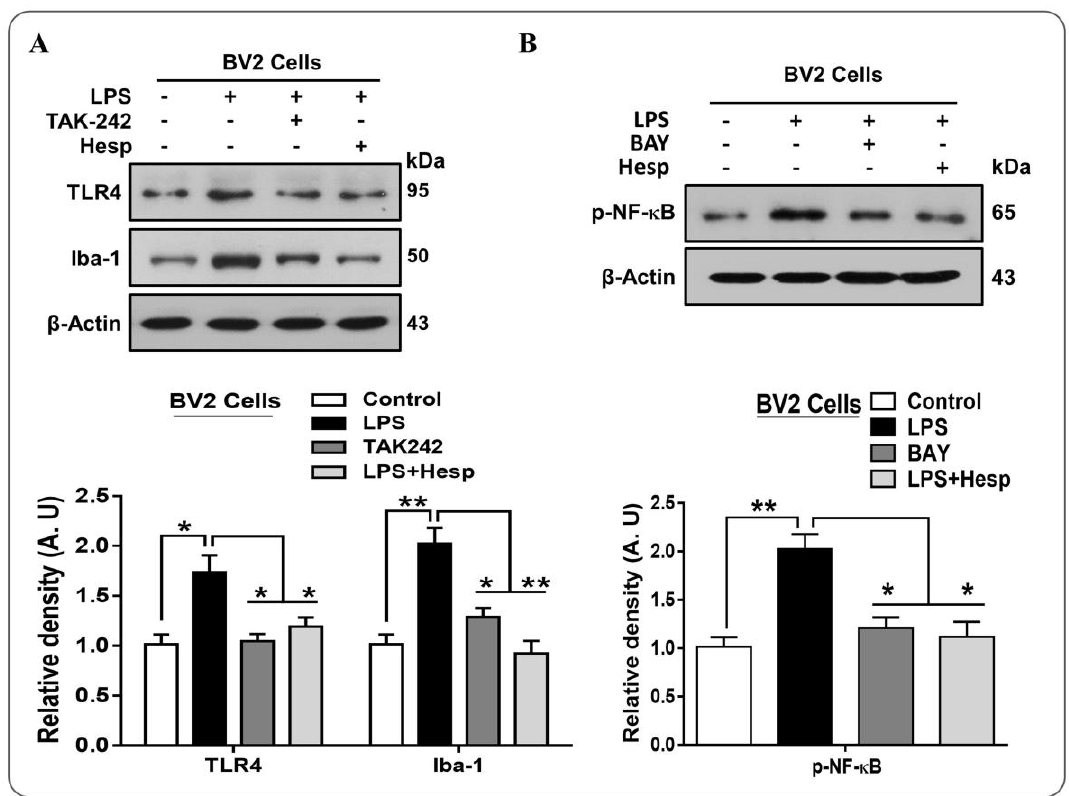
Figure 4. ( A ) Western blot analysis of the TLR4 and Iba-1 expression in BV2 cells treated with hesperetin and TAK-242 (TLR4 inhibitor) and their respective histograms; ( B ) Western blot analysis of p-NF- κ B and TNF- α protein expression level in BV2 cell line treated with LPS and/or hesperetin/BAY (NF- κ B inhibitor). The data are shown as the mean ± SEM of triplicate wells for in vitro experiments are representative of three independent experiments, * p ≤ 0.05, ** p ≤ 0.01.